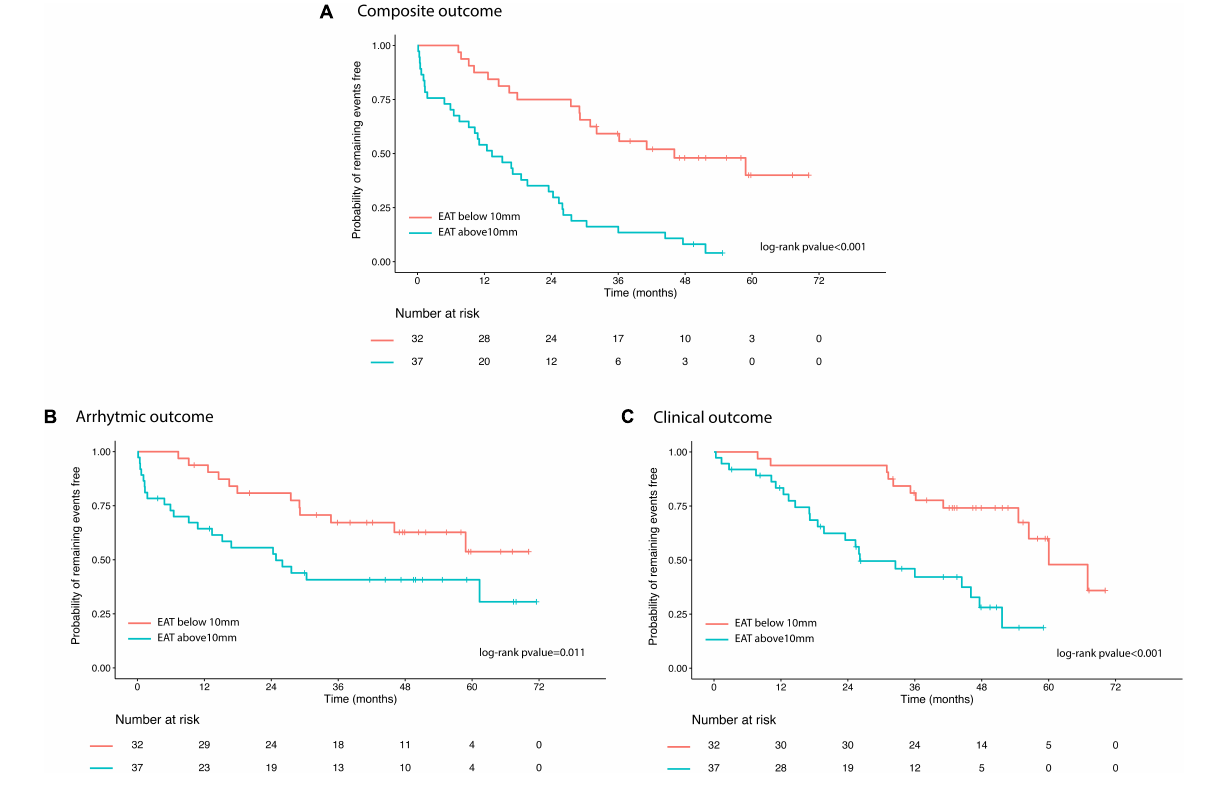
results toward the null (i.e., no significant effect) rather than toward the alternative hypothesis. We are, at the same time, aware of the risk of inflating the probability of type I error due